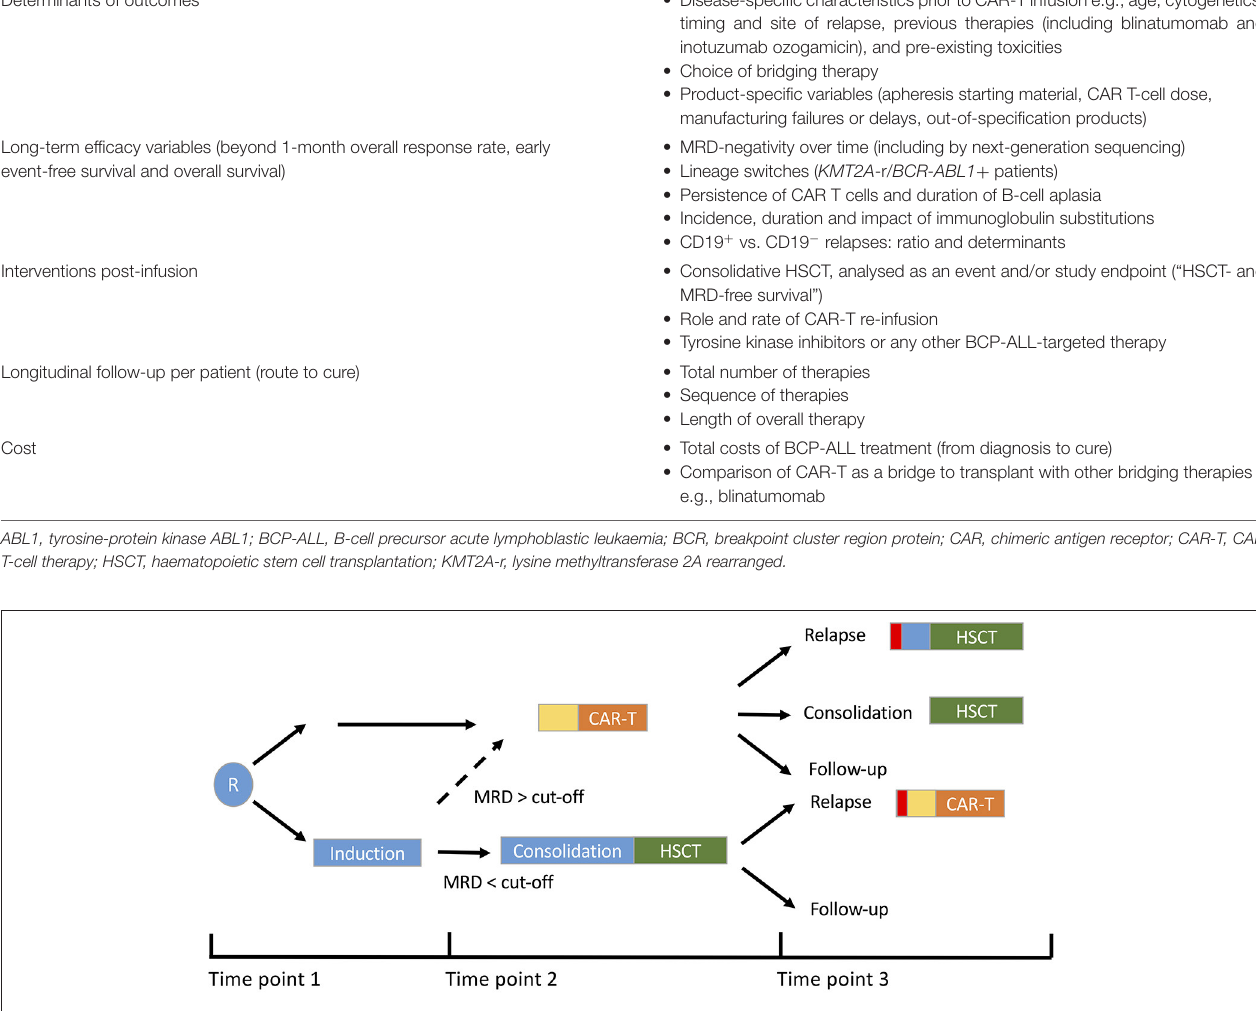
TABLE 4 | Aspects of CAR-T planning, delivery and outcome that could be researched using post-marketing registry data. Theme Example topics of research Determinants of outcomes